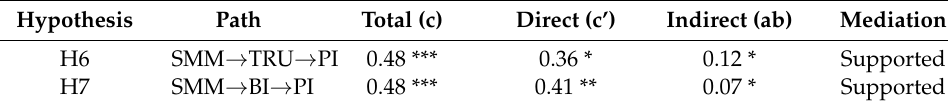
Table 7. Summary of mediation analysis results (post hoc analysis).